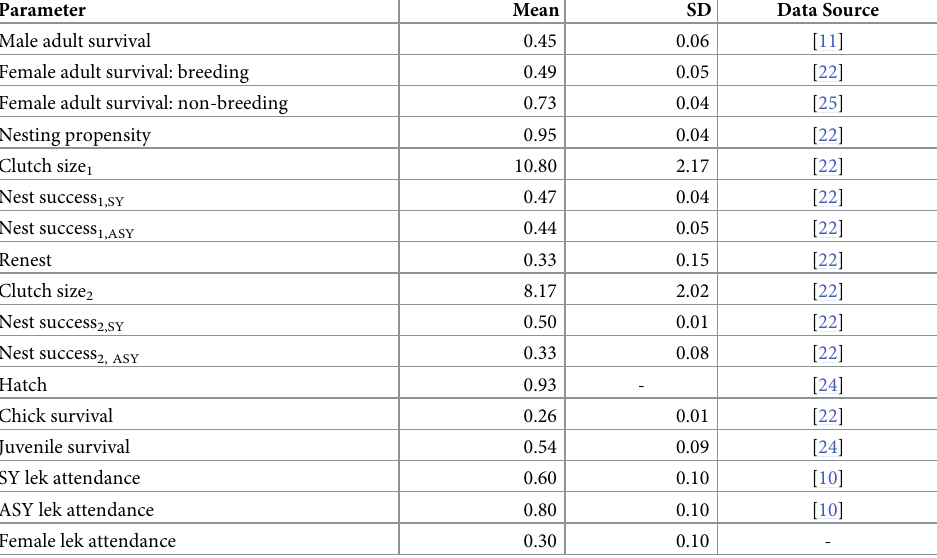
Table 1. Values of demographic parameters used to simulate individual-based models for lesser prairie-chickens in